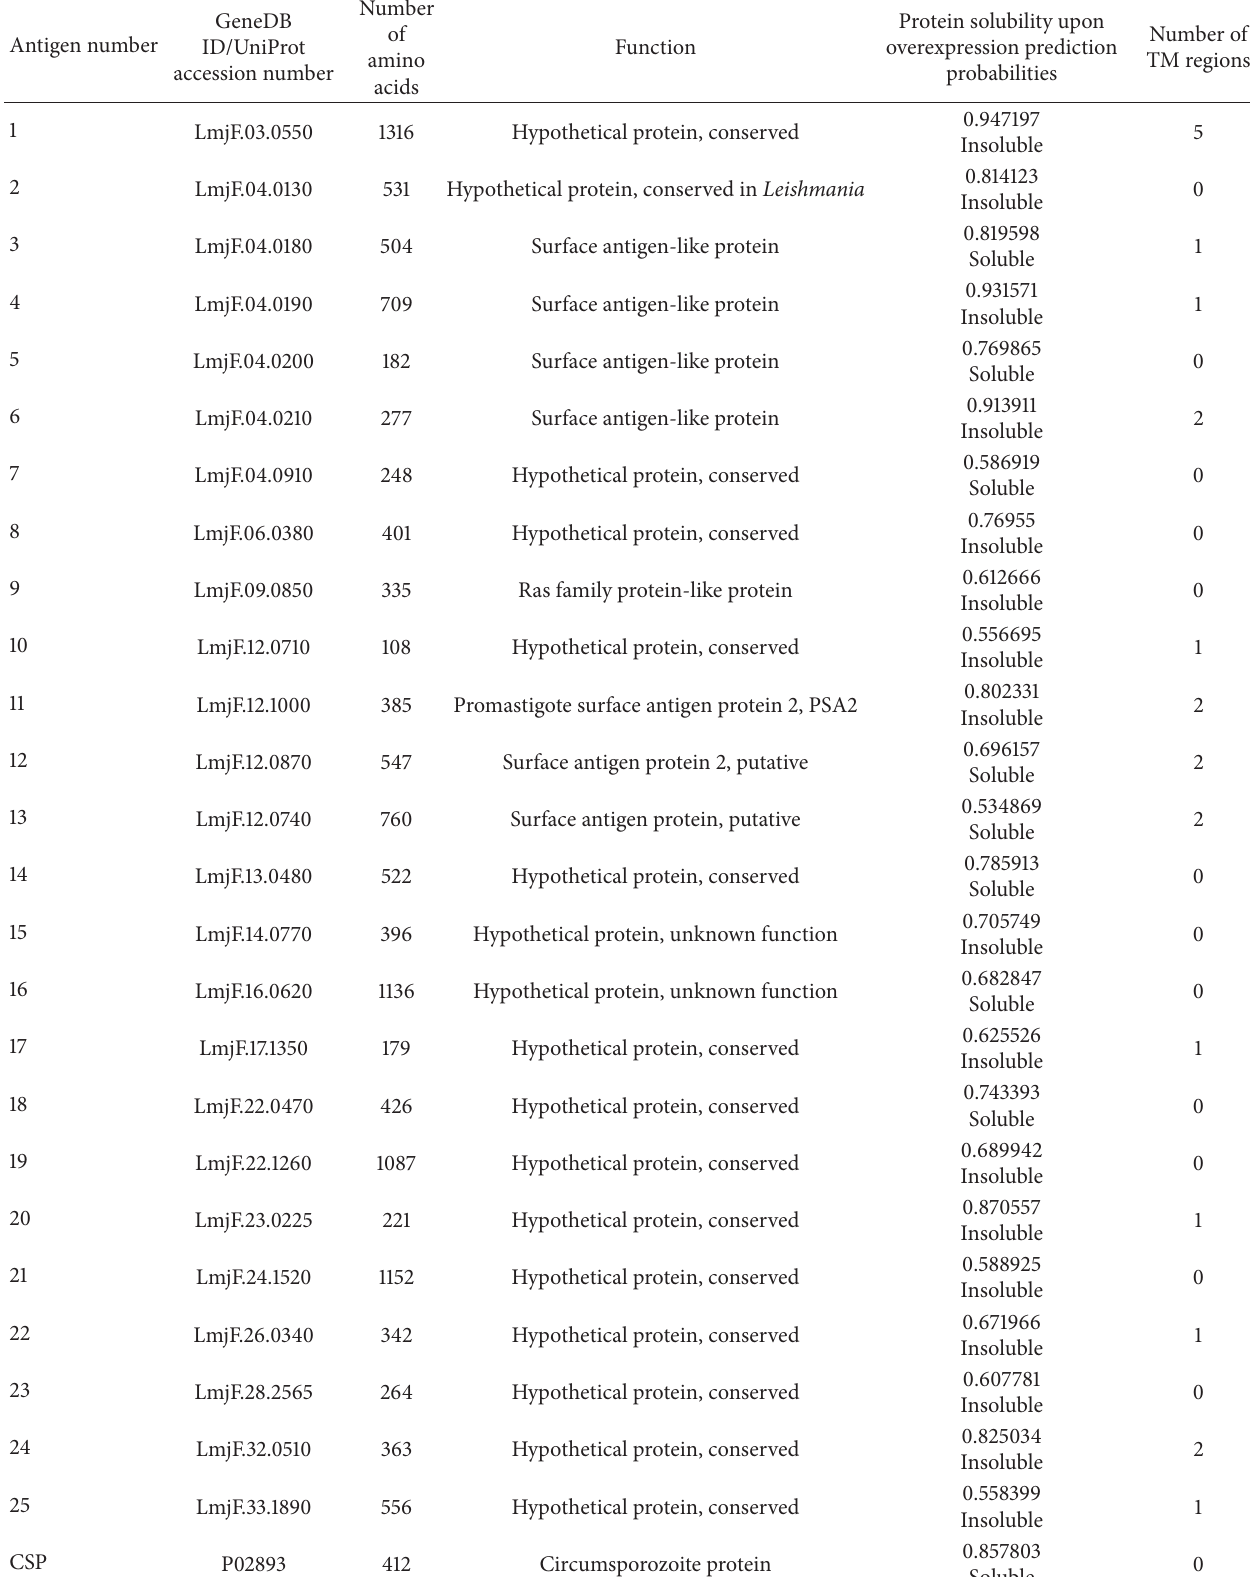
Table 1: List of predicted 25 L. major candidate antigens and 5 control antigens along with their prediction probabilities using SOLpro and TMHMM